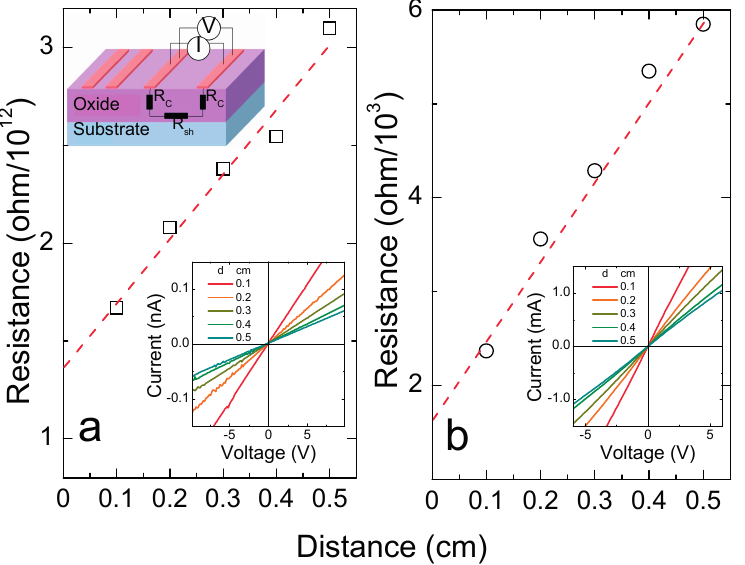
Figure 3. Transfer length method measurements of 15 nm thick MoO 3 films deposited on ( a ) glass and ( b ) n-Si, measured with 40 nm Au electrodes. Insets show the current-voltage measurements at different distance intervals d